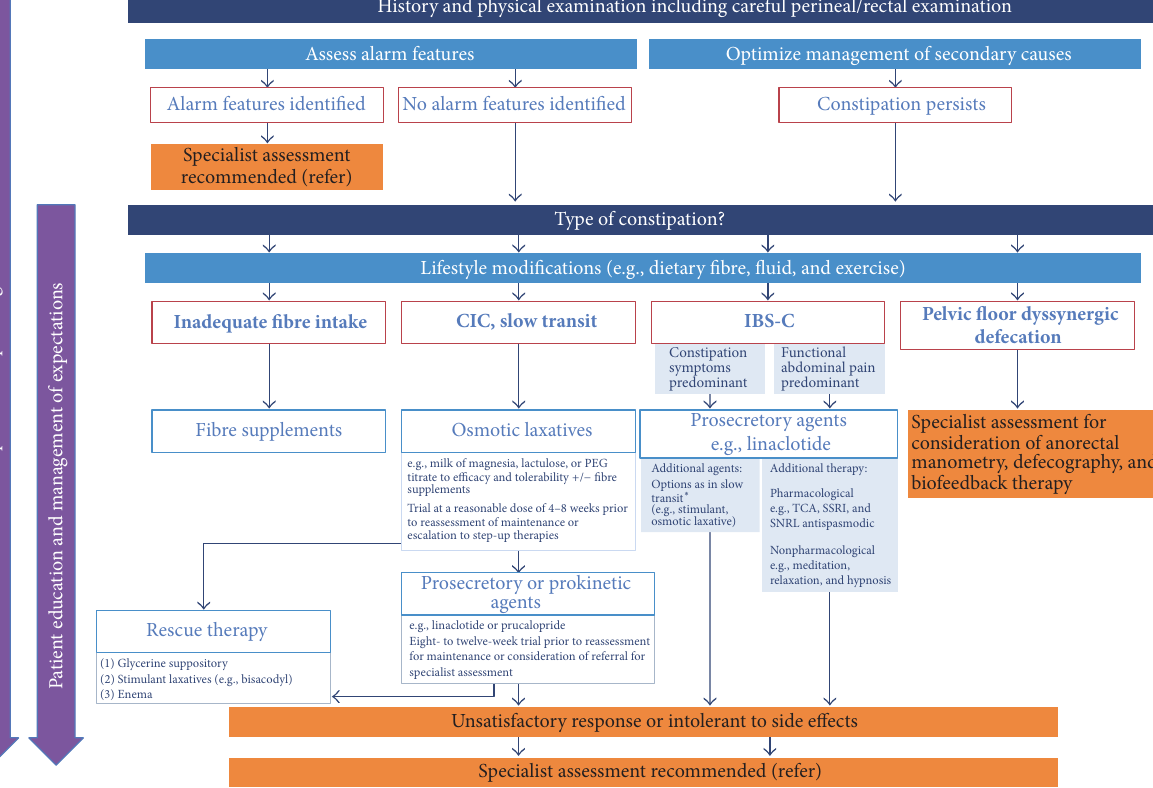
Figure 5: Management algorithm for chronic constipation. The priority usage of each therapeutic option depends on patients’ tolerability and affordability. ∗ 𝑇ℎ𝑒𝑟𝑒 has been no evidence to support the use of prucalopride in patients with IBS-C. (IBS-C : constipation-predominant irritable bowel syndrome)